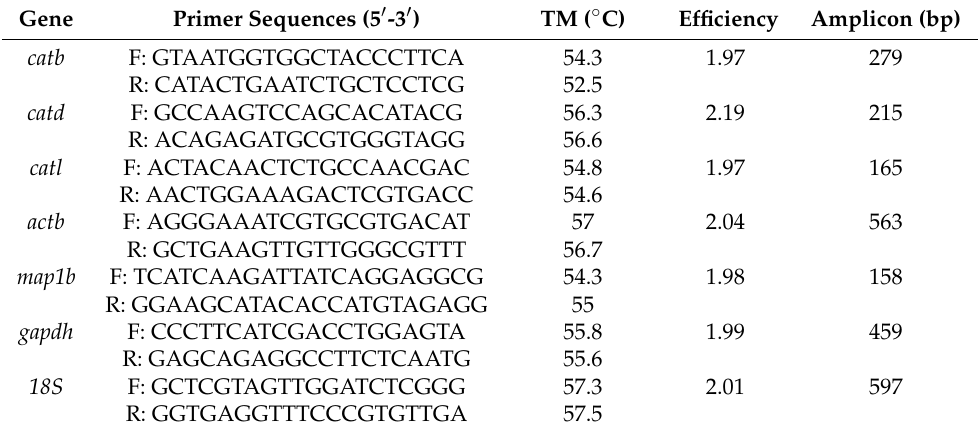
Table 1. Sequences of qPCR